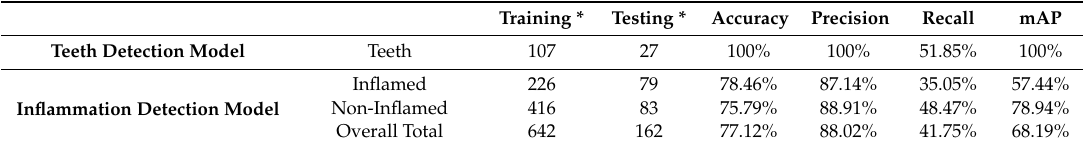
model and inflammation detection model. Table 1. Accuracy, precision, recall, and mean average precision (mAP) for both the teeth detection